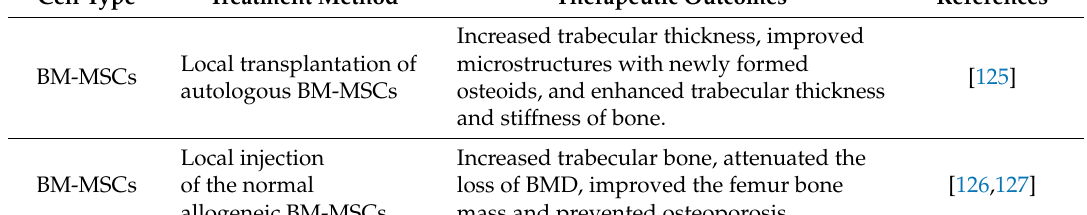
Table 1. Preclinical studies using BM-MSCs and AD-MSCs in the osteoporosis treatment in animal models. Cell